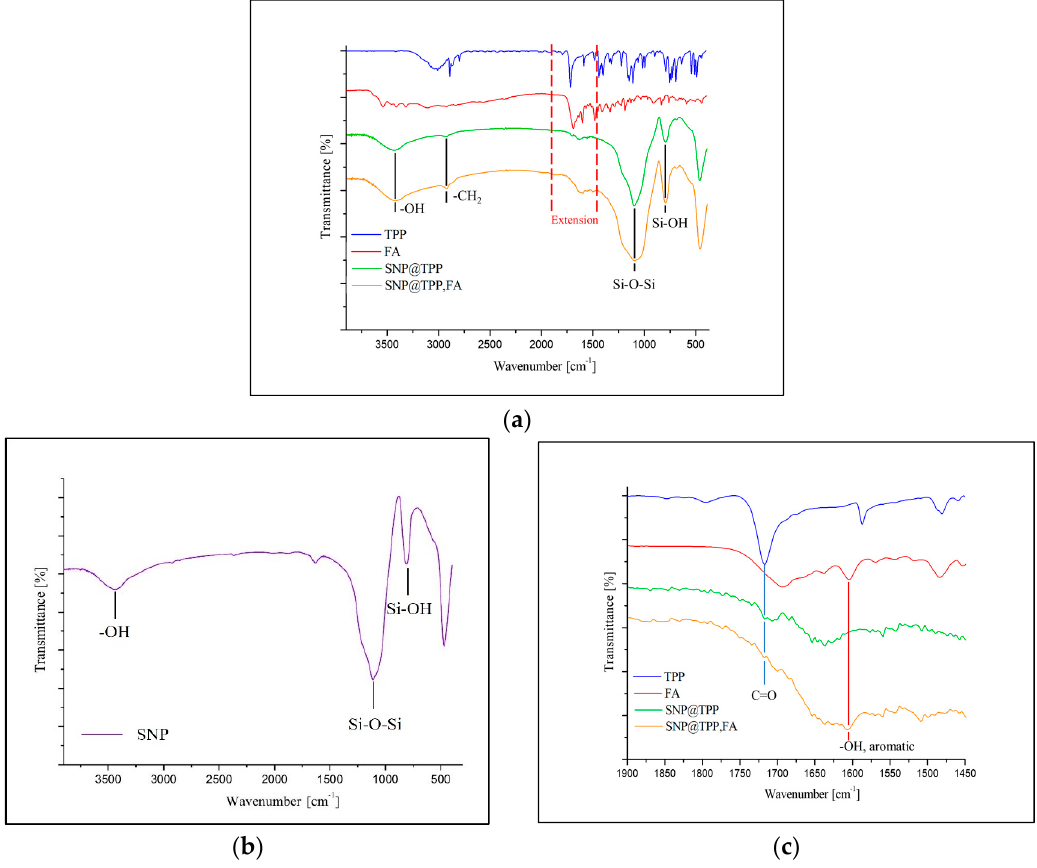
Figure 1. ( a ) FT-IR spectrum of triphenylphosphonium (TPP)- and folic acid (FA)-modified silica nanoparticles (SNPs); ( b ) silica nanoparticle; ( c ) extension spectrum ( a ) at 1450 to 1900 cm − 1 .